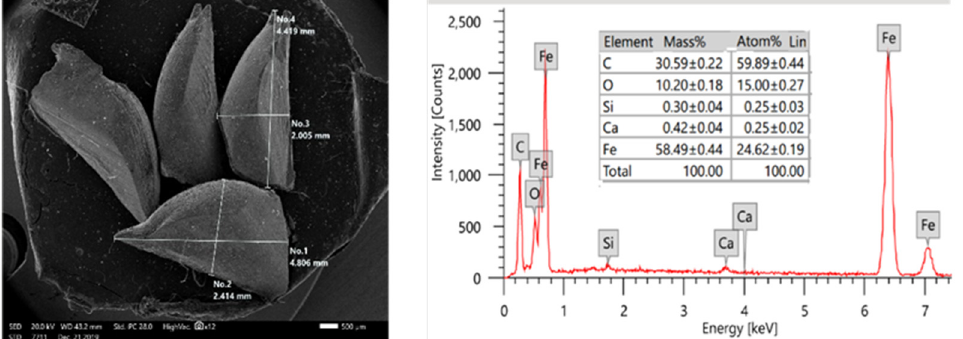
Figure 1. EDX analysis of MNW.